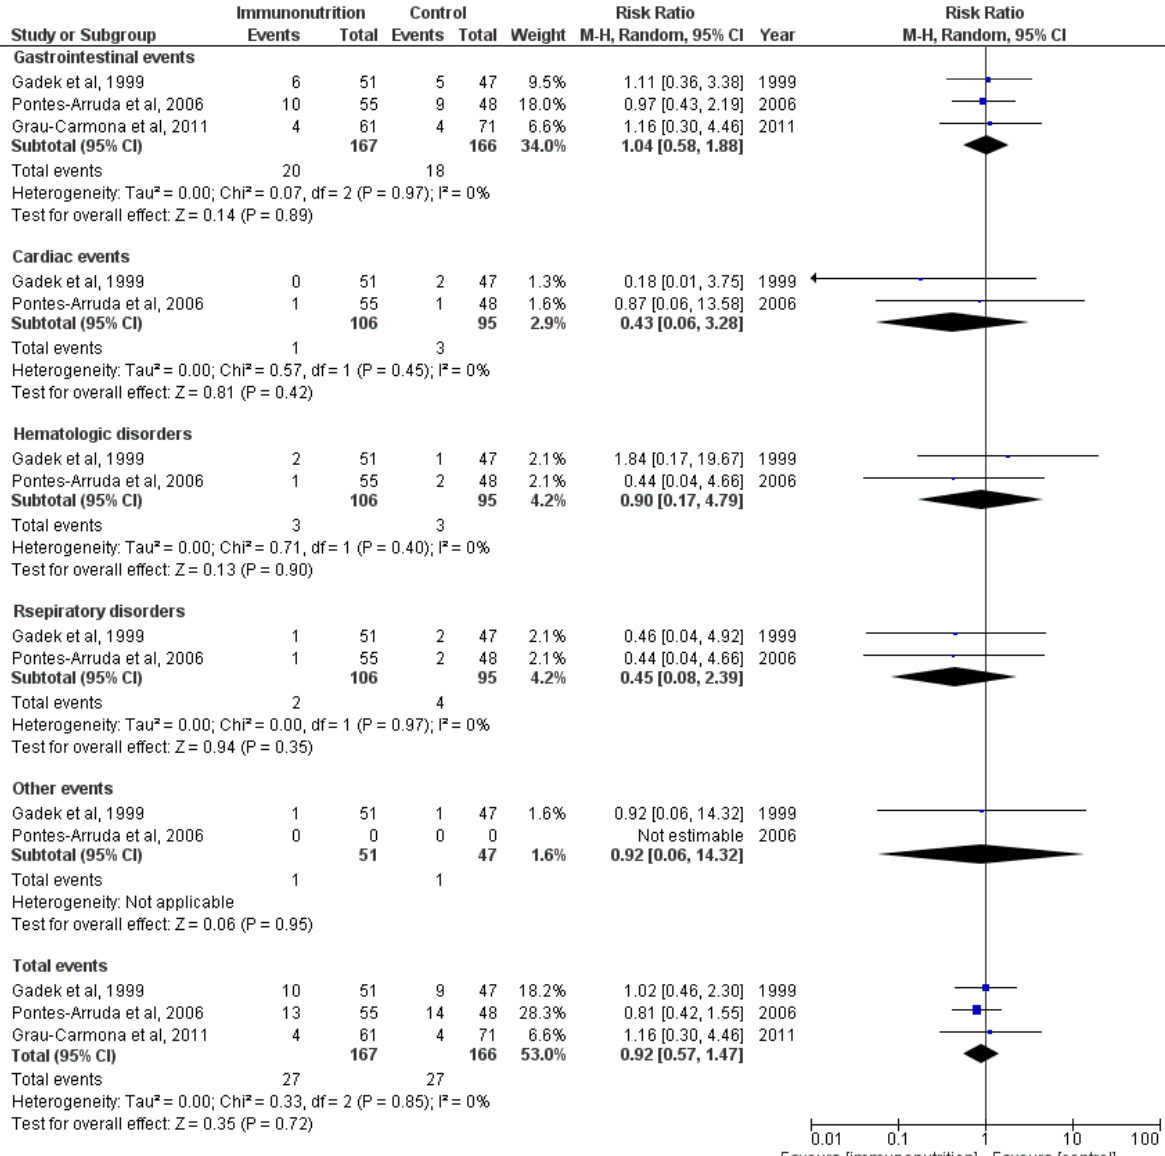
Figure 6. Forest plot of the association between enteral immunomodulatory diet and adverse events among patients with events among patients with ALI/ARDS.